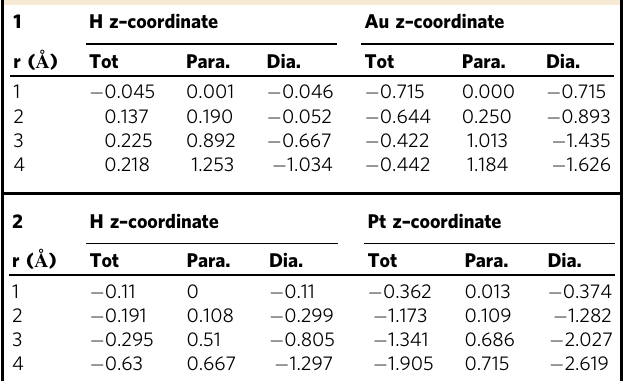
Table 3 Radial integrals of the circularly integrated current strength (Fig. 3) (in Å 2 nA/T) at H and Au or Pt x-y planes at radius r from (0,0,z) respective coordinate in clusters 1 and 2.